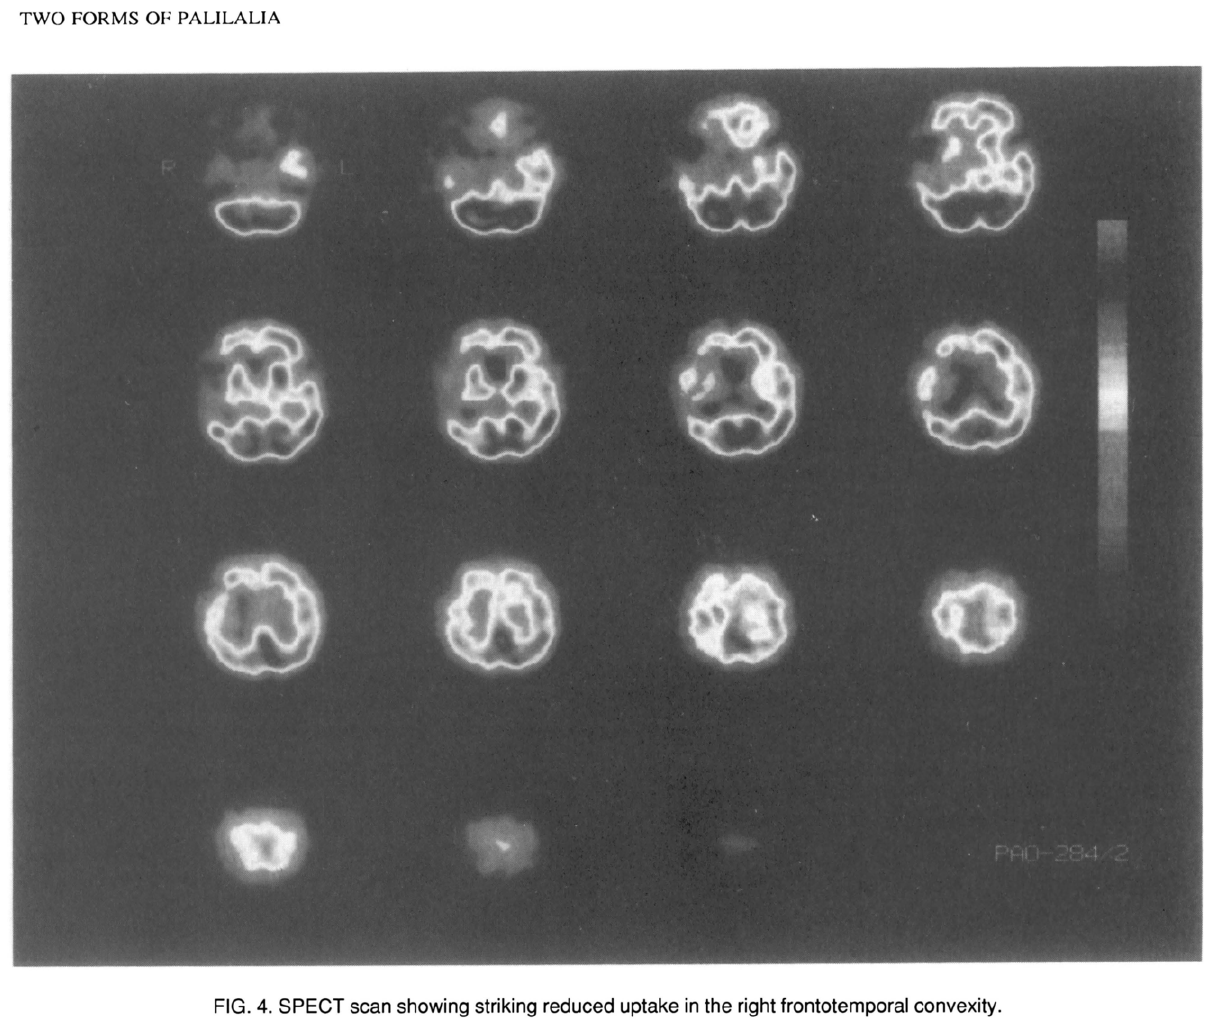
FIG. 4. SPECT scan showing striking reduced uptake in the right frontotemporal